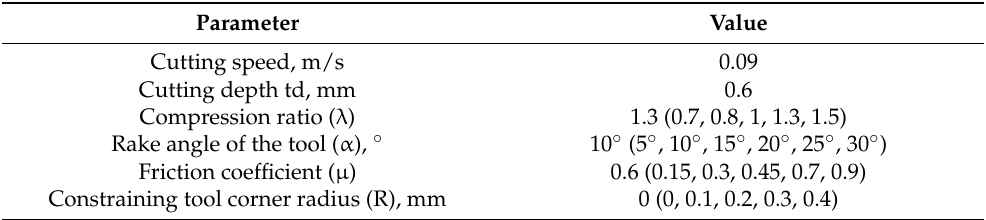
Table 2. Parameters in experiment (variable are filled in the